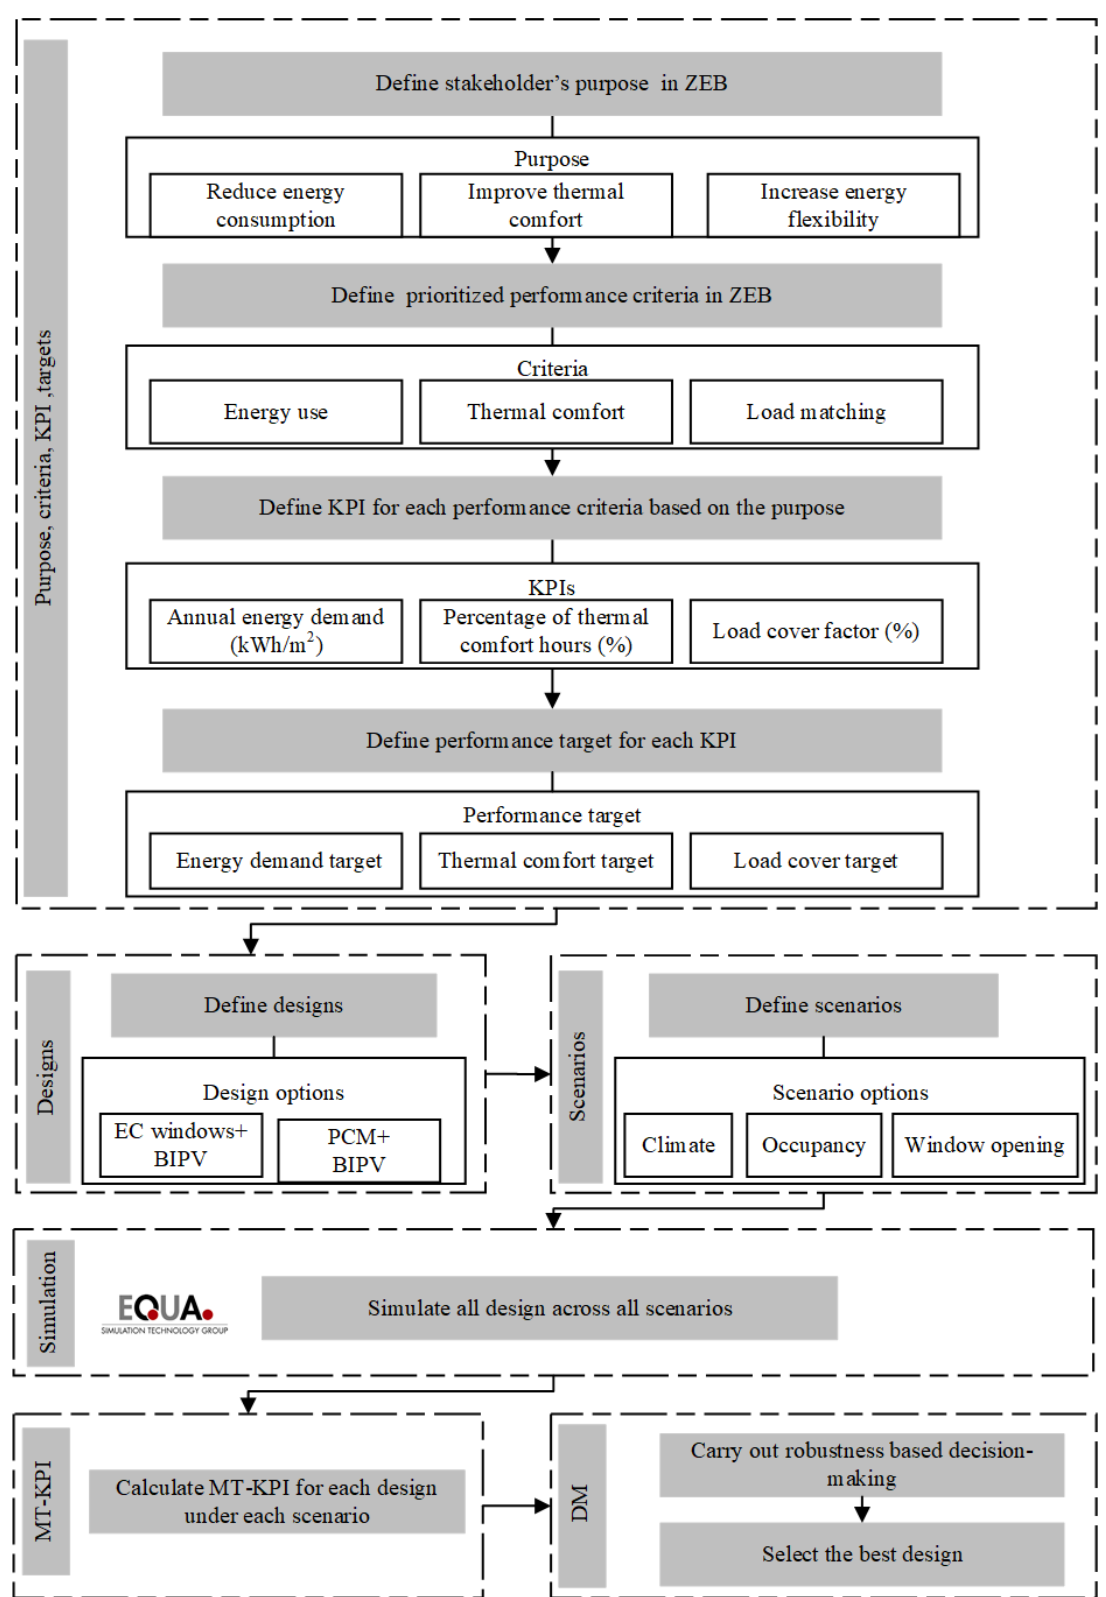
Figure 2. Methodological approach proposed in this article. The main general steps are in the grey boxes.